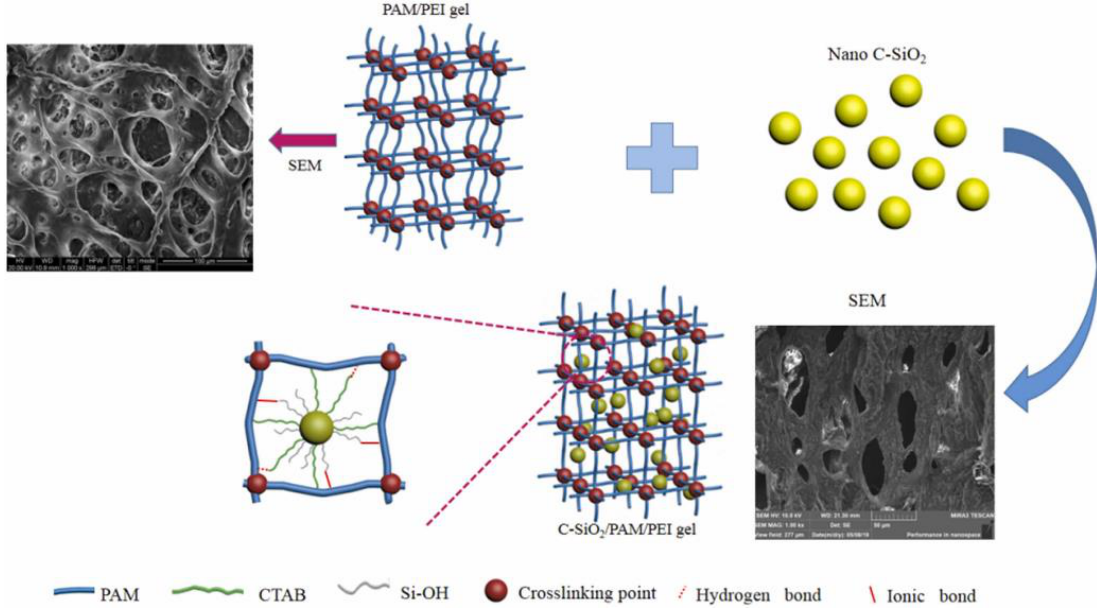
Figure 12. The schematic diagram of mechanism of C-SiO 2 /PAM/PEI withstands long-term stability. (Reprinted/adapted with permission from Ref. [73]. 2022, Li, et al”) .